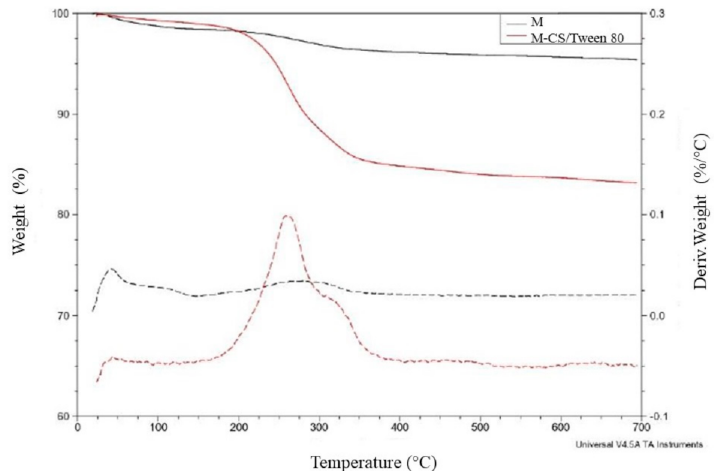
Figure 4. TGA spectrum. The weight loss of microspheres, from 250 to 350 ◦ C, is given by the presence of chitosan and Tween